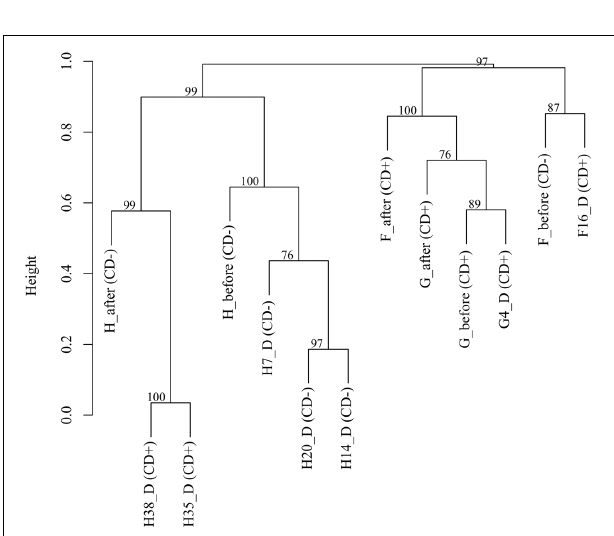
FIGURE 2 | Cluster analysis based on OTUs (97%) of CDI patients (F, G, and H). The approximate unbiased (AU) p -values are shown.